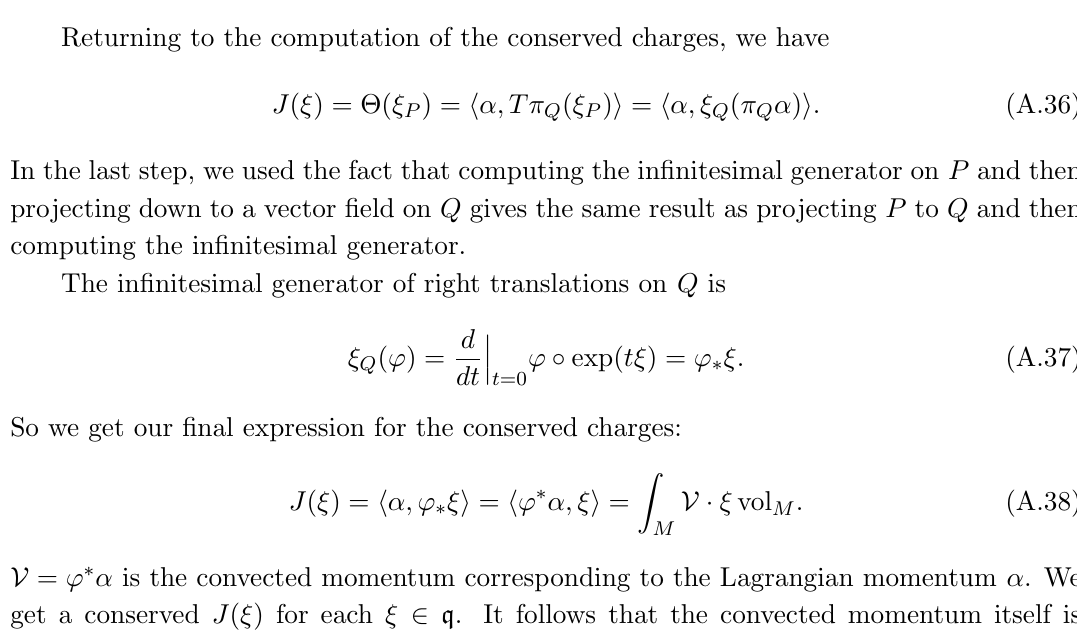
Figure 3 . The Lagrangian, Eulerian, and convected momenta are related by a triangle of